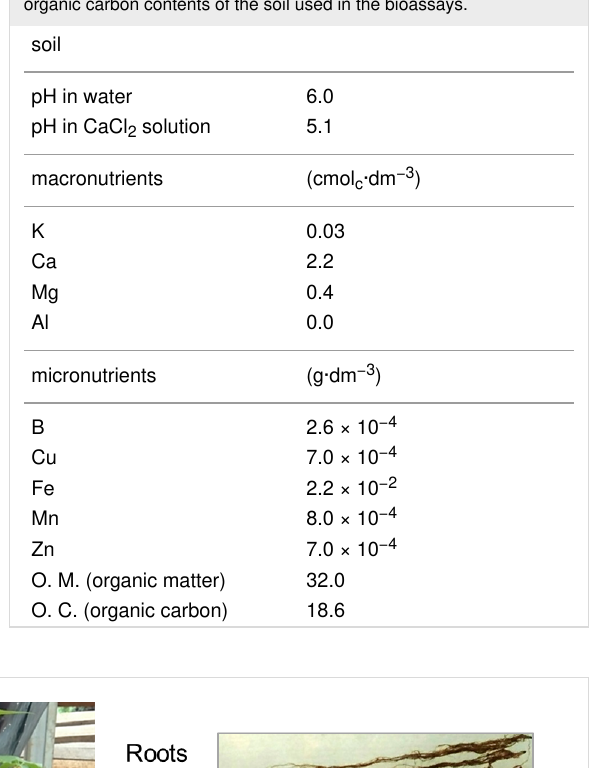
which present the chemical composition shown in Table 2. A